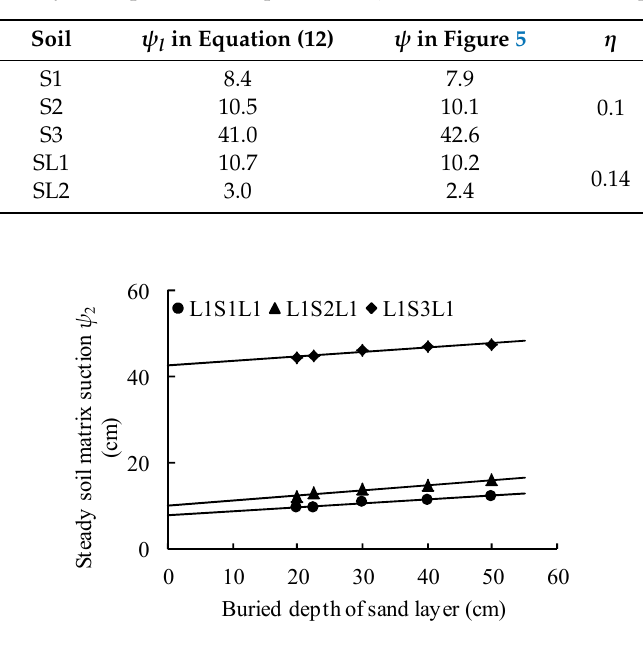
Figure 5. The variation of the simulated soil matrix suction at the upper interface of the two soils with the buried depth of sand layer for cases L1S1L1, L1S2L1, and L1S3L1 during the steady infiltration stage. Table 3. The water entry suction for homogeneous soils in Equation (12) and in Figure 5 when the buried depth of sand layer is equal to 0, and parameter for the two infiltration experiments.